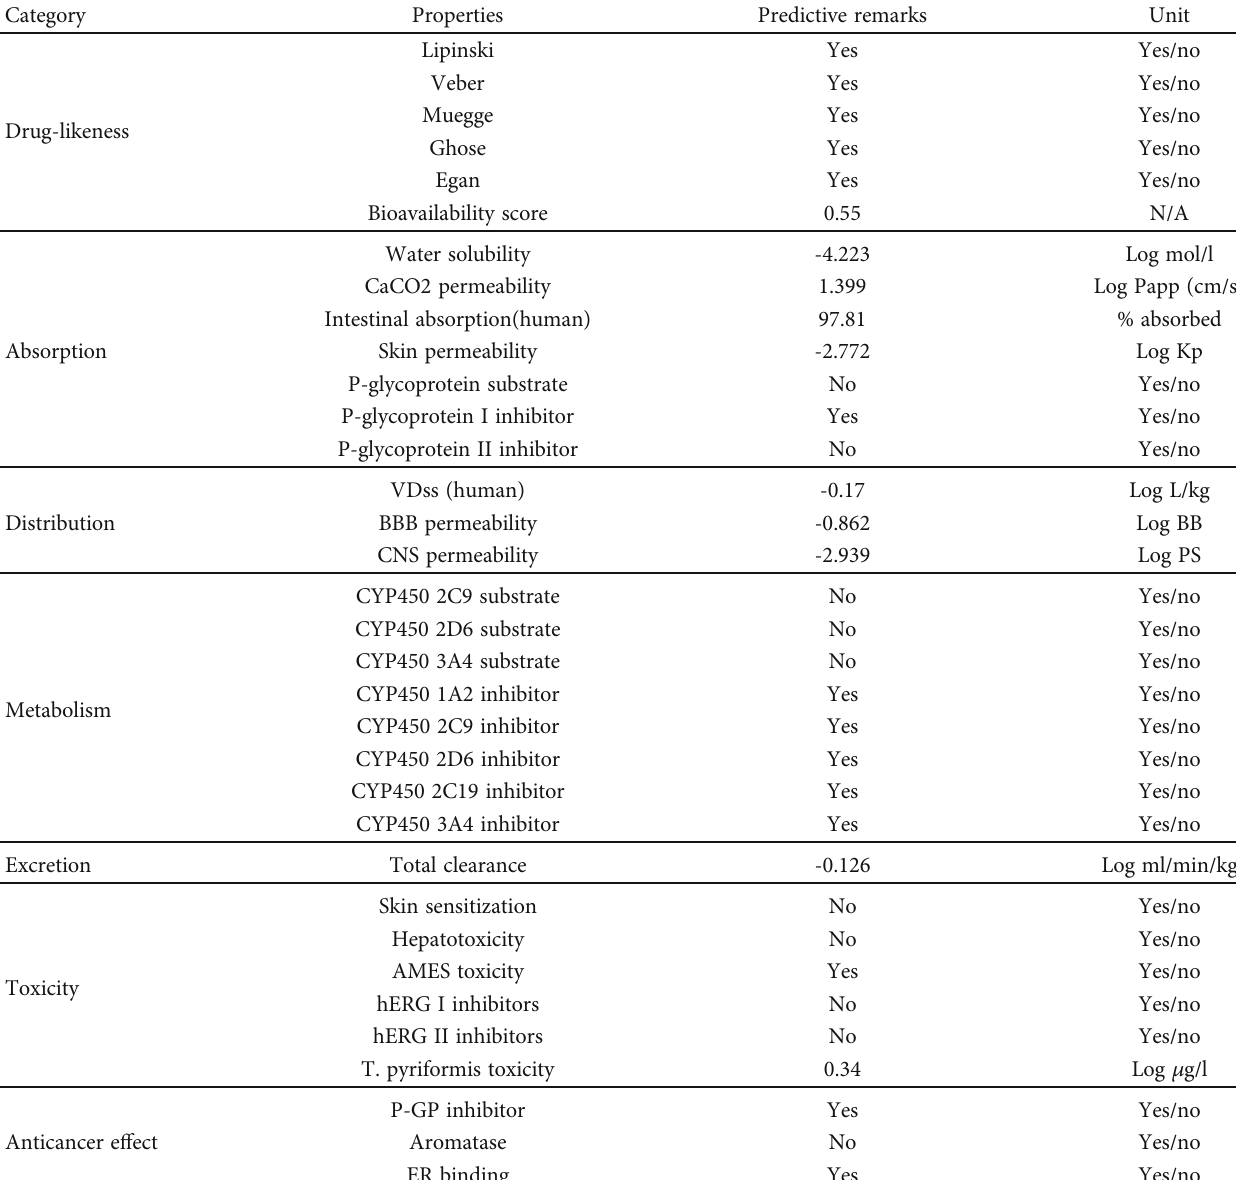
Table 3: Drug availability evaluation pro fi le